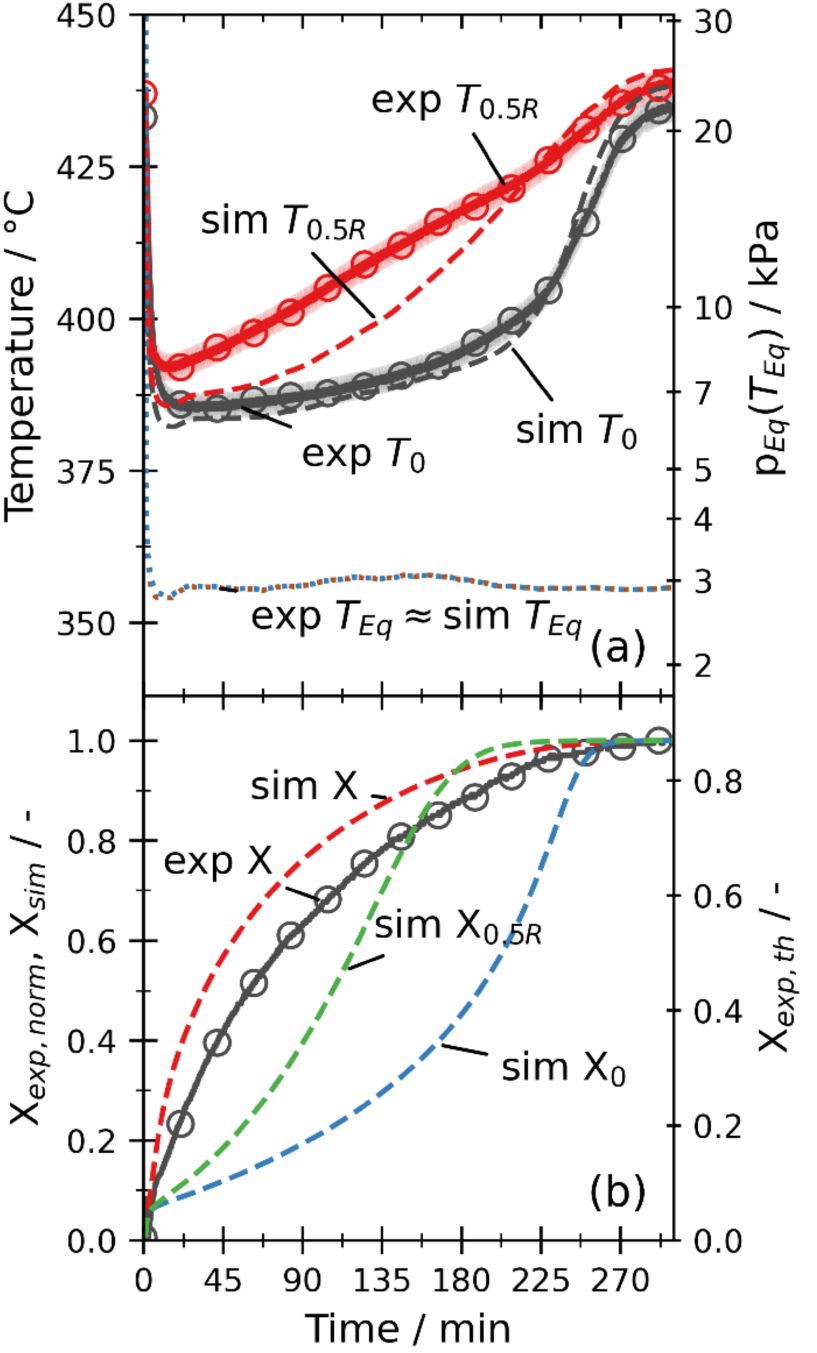
Figure 7. Comparison of the experimental and numerical results of temperatures ( a ) and conversions ( b ) for E7. Here, an enhanced permeability by the factor 100 is used for the simulation. MAEs are 2.8 K for T 0 , 6.2 K for T 0.5R , and 0.08 for the